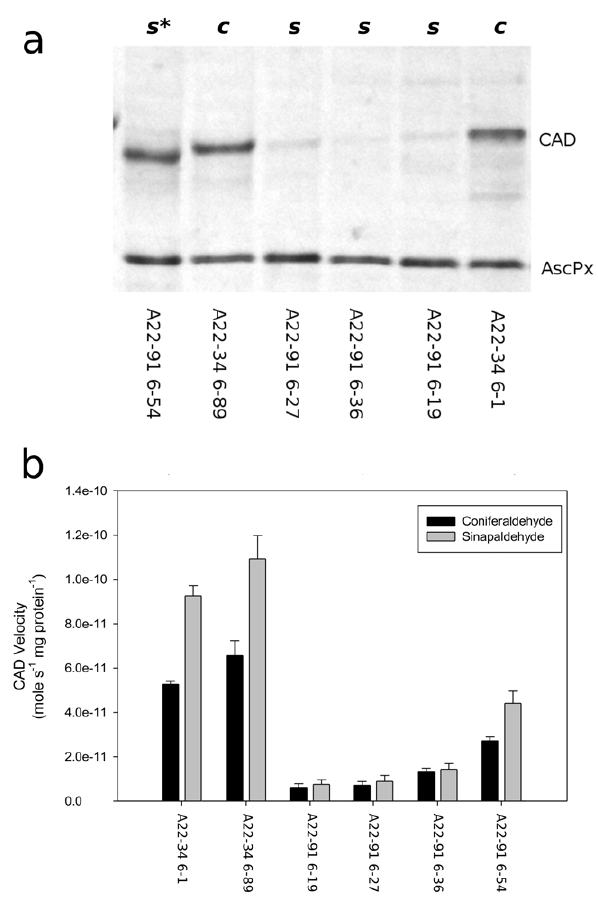
Figure 4. CAD protein expression and enzyme activity in selected CAD silenced individuals. ( a ) Protein immunoblot of silenced individuals ( s ) or control individuals ( c ) indicated above the panel. The positions of the CAD and ascorbate peroxidase (AscPx) proteins are indicated to the right of the panel. An individual producing an immunoreactive protein with altered mobility is indicated by an asterisk. ( b ) Enzyme activity in stem extracts using the substrates coniferaldehyde (black bars) and sinapaldehyde (grey bars). Bars indicate standard error associated with each sample.